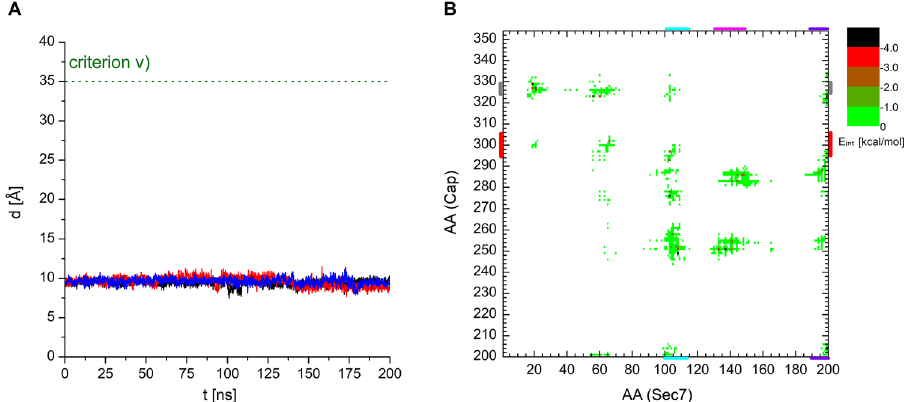
Figure 4. ( A ) Evolution of the filtering parameter v) , the distance between the C α atoms of the Sec7 domain residue F137 and Capping domain residue F255, during the three concurrent 200 ns MD runs starting from the closed, autoinhibited RalF conformation. ( B ) Interaction energy map between the residues of the Sec7 and the Capping domain, calculated on the conformations retrieved from the three MD